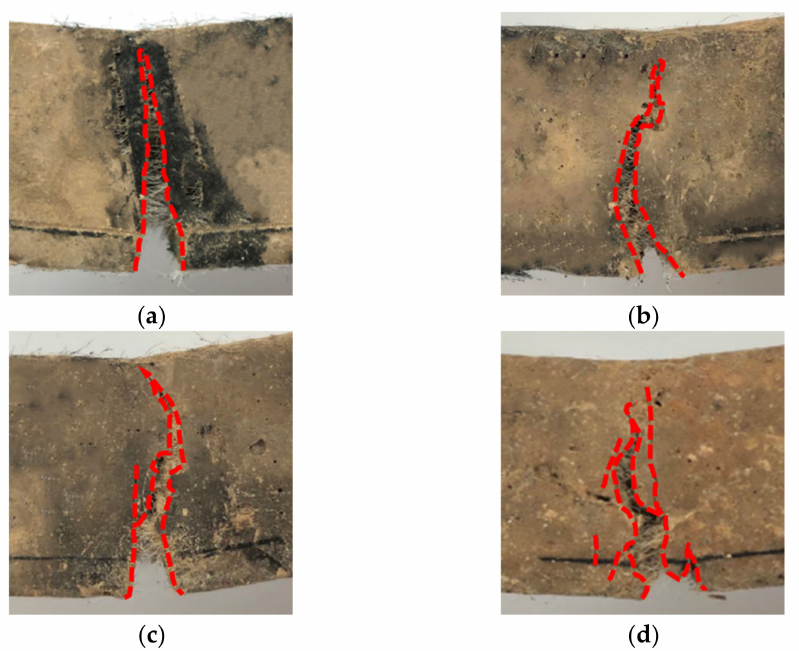
Figure 9. Final crack path of notched specimens with 1% fiber content specimens. ( a ) PVA; ( b ) AN; ( c ) AH; ( d ) AK.